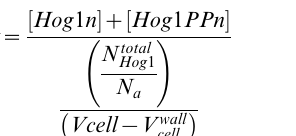
Figure S5 Model predictions for nuclear phosphorylated Hog1 (Hog1PPn) response to different periodic square pulses of 0.2 M NaCl. In all cases, the on time (T on ) and off time (T off ) of square pulses are half of the period time (T 0 ): T on = T off =T 0 /2. D I s : NaCl integral change, D I h : integral change of Hog1PPn response, G s : Hog1PPn response gain. Found at: doi:10.1371/journal.pone.0009522.s005 (0.50 MB TIF) Figure S6 Relationship between nuclear phosphorylated Hog1 (Hog1PPn) response and the duration of periodic square pulses of NaCl change. D I h : integral change of Hog1PPn response. G s : Hog1PPn response gain. Found at: doi:10.1371/journal.pone.0009522.s006 (0.33 MB TIF) Figure S7 Model prediction for nuclear phosphorylated Hog1 (Hog1PPn) response to ramp increase of NaCl. Found at: doi:10.1371/journal.pone.0009522.s007 (0.24 MB TIF) Figure S8 Comparison of the data fitting of the LIT concise model and our new model for periodic square pulses of 0.2 M NaCl. The red circle points are the experimental data sets in Fig. S2 of the reference (Mettetal et al ., Science, 2008, 319: 482–484). Found at: doi:10.1371/journal.pone.0009522.s008 (1.01 MB TIF) Figure S9 Comparison of the data fitting of the LIT concise model and our new model for different periodic square pulses of NaCl stimulation. The red circle points are the experimental data sets in Fig. S5 of the reference (Mettetal et al ., Science, 2008, 319: 482–484). Found at: doi:10.1371/journal.pone.0009522.s009 (0.97 MB TIF) Figure S10 The total amount of phosphorylated Hog1 (x 1 , Hog1PP, quantified as % of total Hog1), nuclear Hog1 enrichment (x 2 , nuclear Hog1) and nuclear phosphorylated Hog1 (x 3 , Hog1PPn) are highly correlated under different types of NaCl stimulation. Numbers in the squares of the correlation map (A, F, K) denote the correlation coefficients of two variables. Numbers within parentheses correspond to the rounded p-values for testing the hypothesis of uncorrelated variables. If the p-value is small ( , 0.05), then the correlation of the two variables is significant. The correlation coefficient and p-values were calculated with the ‘‘corrcoef’’ function in Matlab. (A–E) Simple step increase of NaCl. (F–J) Periodic square pulses of NaCl. (K–O) Up-staircase increase of NaCl. Table S1 Initial conditions of the state variables. Table S2 Complete list of model parameter values. Table S3 Complete list of ordinary differential equations and other